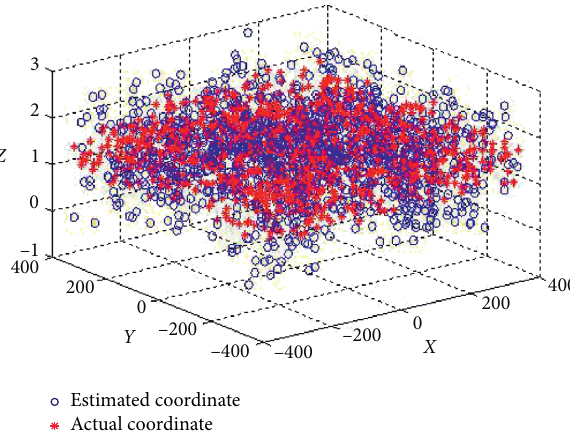
Figure 5: 3D location results under Test data 1.